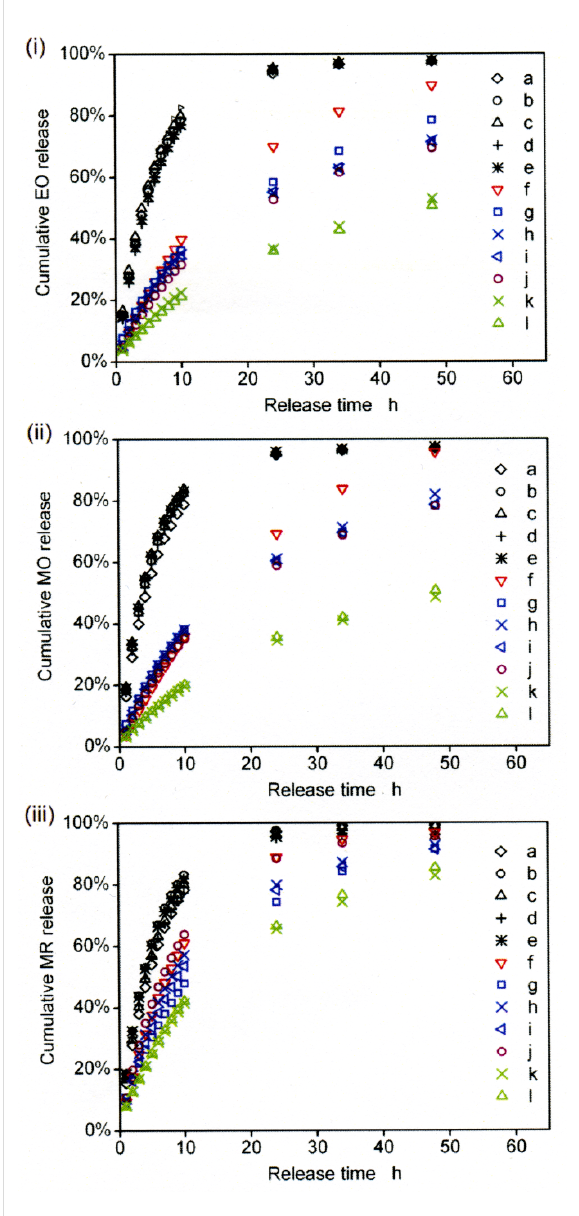
Figure 12: Release profiles for EO (i), MO (ii) and MR (iii) from aqueous (a) Na 2 HPO 4 /KH 2 PO 4 buffer alone, (b) 1.20 wt % PAA, (c) 1.20 wt % PAA/PAAADddn, (d) 1.18 wt % PAA/PAAADhn, (e) 1.14 wt % PAA/PAAADen, (f) 1.20 wt % PAA/ β -CD, (g) 1.20 wt % PAA β -CDen/PAAADddn, (h) 1.18 wt % PAA β -CDen/PAAADhn, (i) 1.14 wt % PAA β -CDen/PAAADen, (j) 1.18 wt % PAA/PAA β -CDen, (k) 1.96 wt % PAA β -CDen/PAAADhn, and (l) 1.89 wt % PAA β -CDen/ PAAADen all in aqueous Na 2 HPO 4 /KH 2 PO 4 buffer at pH 7.0, I = 0.10 mol dm − 3 and 298.2 K. Initial [dye] = 2.00 × 10 − 3 mol dm − 3